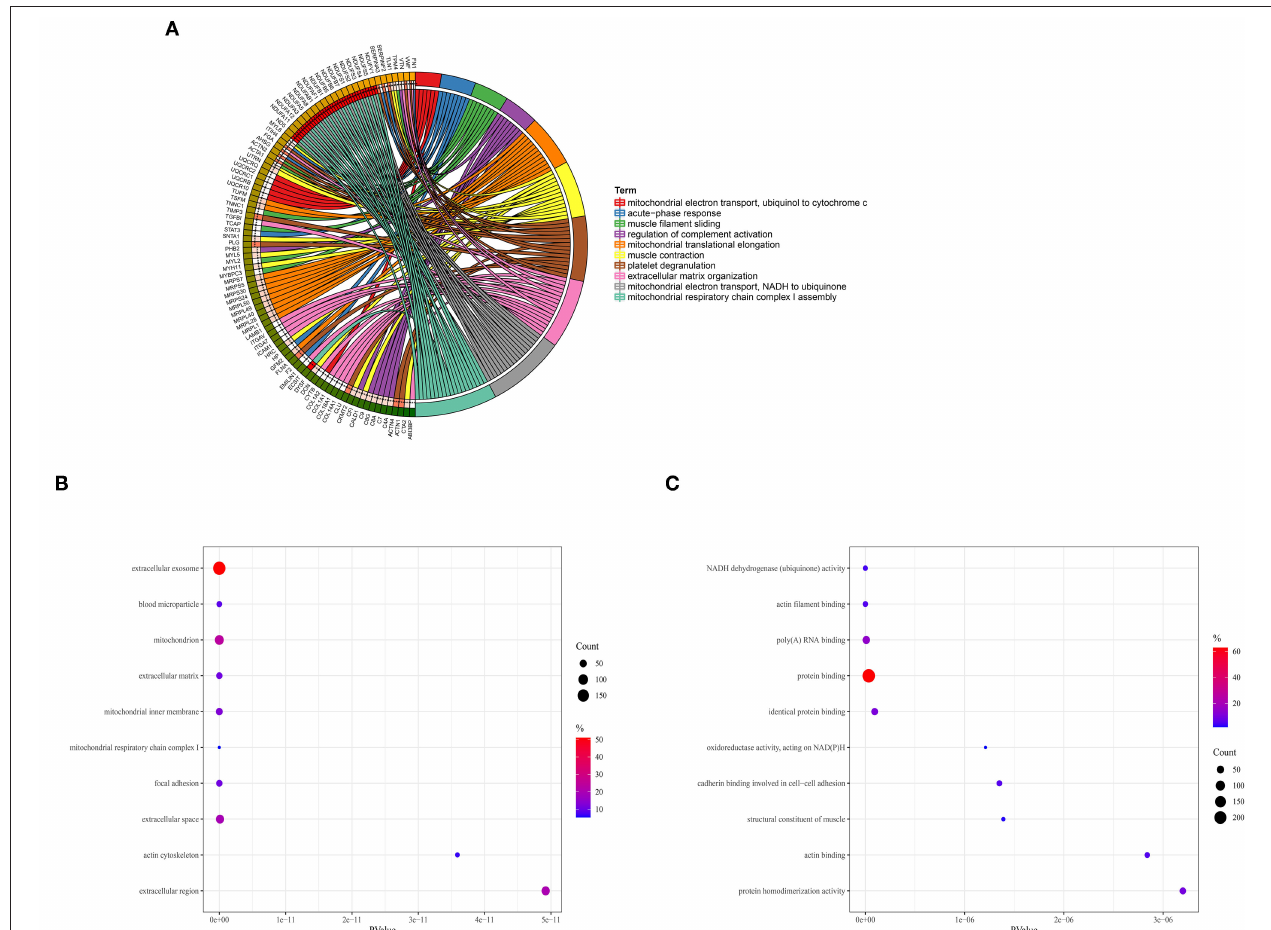
FIGURE 2 | Gene Ontology enrichment analysis. (A) Biological process. (B) Cellular component. (C) Molecular